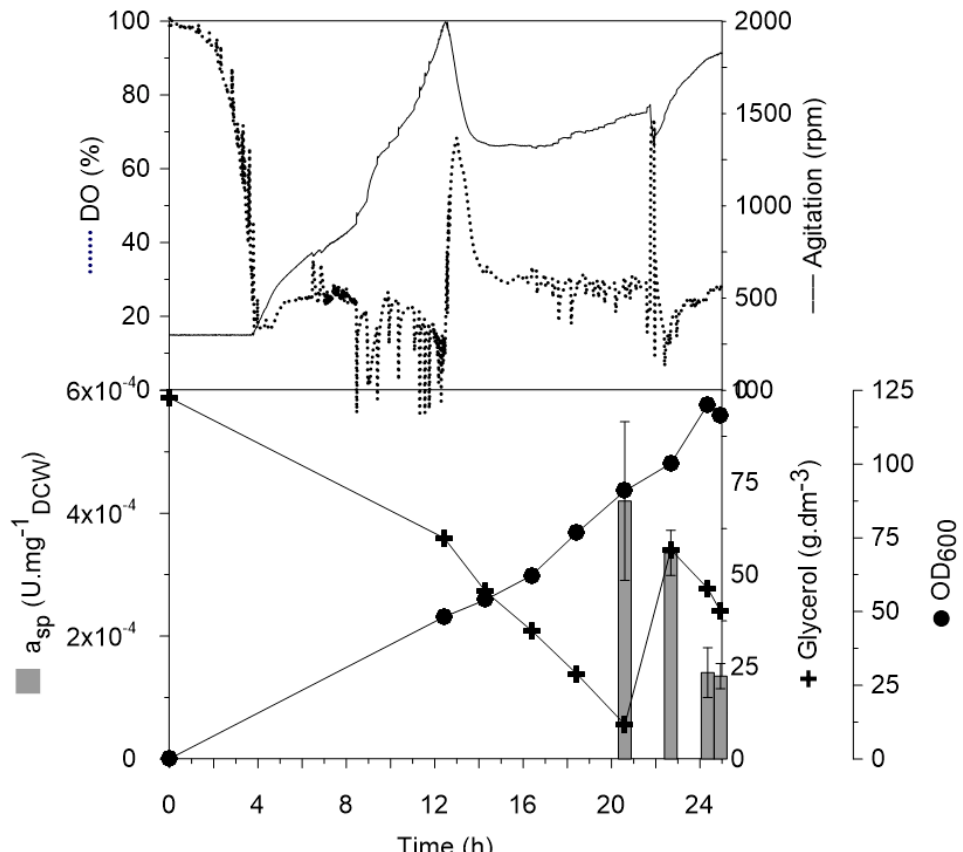
Figure 2. Fed ‐ batch cultivation of E. coli BL21(DE3) expressing LOX. DO − dissolved oxygen (%), OD 600 − optical density of culture determined at 600 nm; a sp − specific activity of E. coli whole cells expressing LOX.